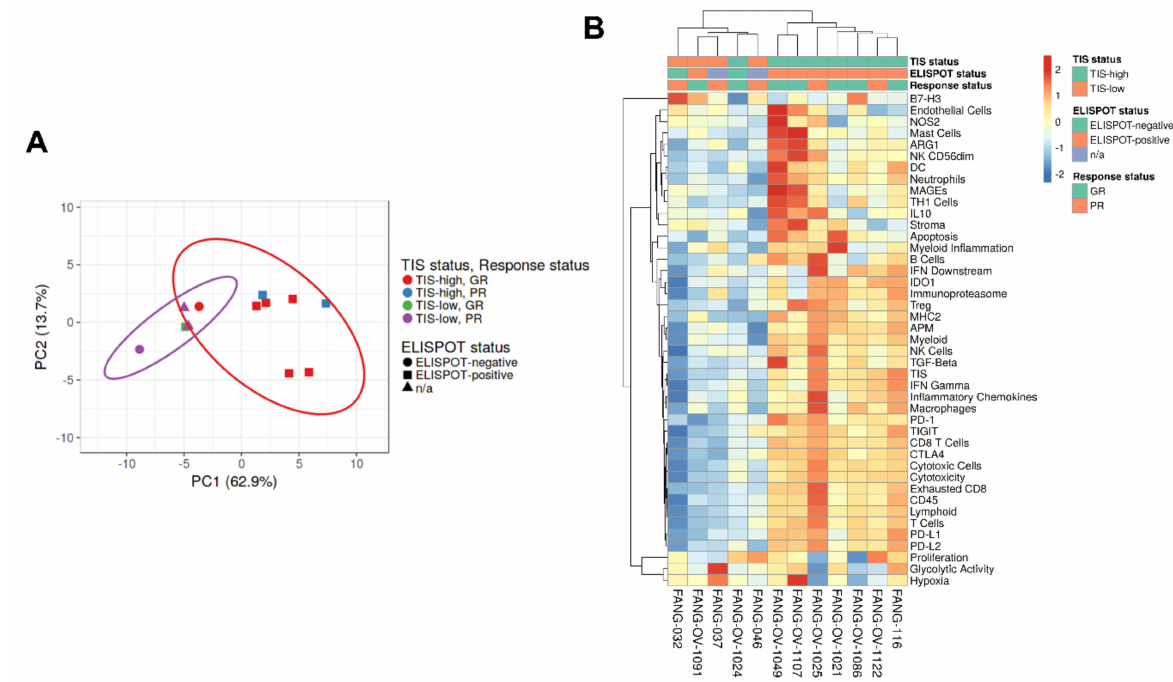
Figure 3. Principal component analysis (PCA) was completed to detect intrinsic clusters between responders to Vigil treatment and γ -IFN-ELISPOT reactivity post-Vigil treatment as well as possible outliers. TIS HIGH good responders (Tumor inflammation score (TIS)) > 6, OS > 12months) post-Vigil treatment = red; TIS HIGH poor responders (TIS score > 6, OS < 12months) post-Vigil treatment = blue; TIS LOW good responders (TIS score < 6, OS > 12months) post-Vigil treatment = green; TIS LOW poor responders (TIS score < 6, OS < 12months) post-Vigil treatment = purple; γ -IFN-ELISPOT- negative = circles; γ -IFN-ELISPOT-positive = squares; post-Vigil; γ -IFN-ELISPOT not evaluable = triangle ( A ) Heatmap of immune pathways stratified by TIS status, response to Vigil therapy and γ -IFN-ELISPOT status. Blue scale indicates under-expressed genes and red scale upregulated genes ( B